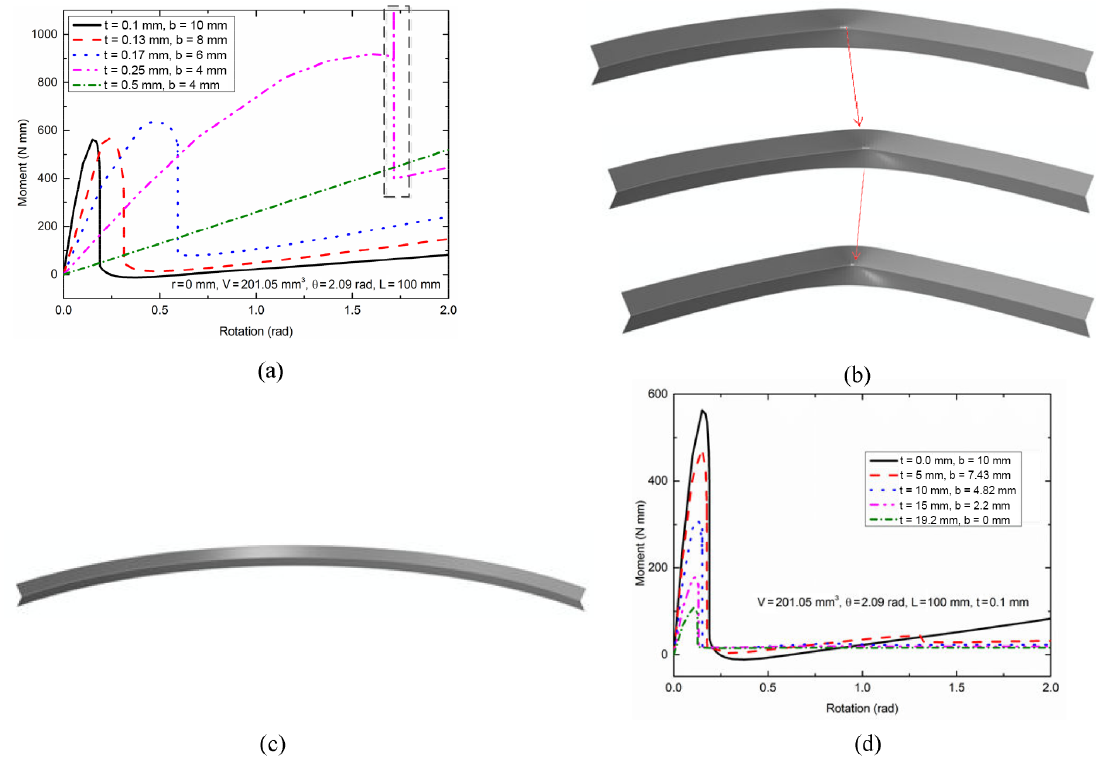
Figure 9. (a) Moment-rotation relationships obtained from finite element modelling showing the influence of the width of the rectangular facet ( b ) and the thickness of strip ( t ) on the mechanical response of the strip of r = 0 when the volume ( V ) and the length ( L ) of the strip were constant, (b) the travelling of the localized fold during bending for the creased strip when t = 0 . 25mm and b = 4mm, (c) deformed shape of the creased strip when t = 0 . 50mm and b = 2mm, and (d) moment-rotation relationships obtained from finite element modelling showing the influence of the radius of the crease curvature ( r ) and the width of the rectangular facet ( b ) on the mechanical response with fixed values of the thickness of strip ( t ), the initial opening angle ( θ ), the volume ( V ), and the length ( L